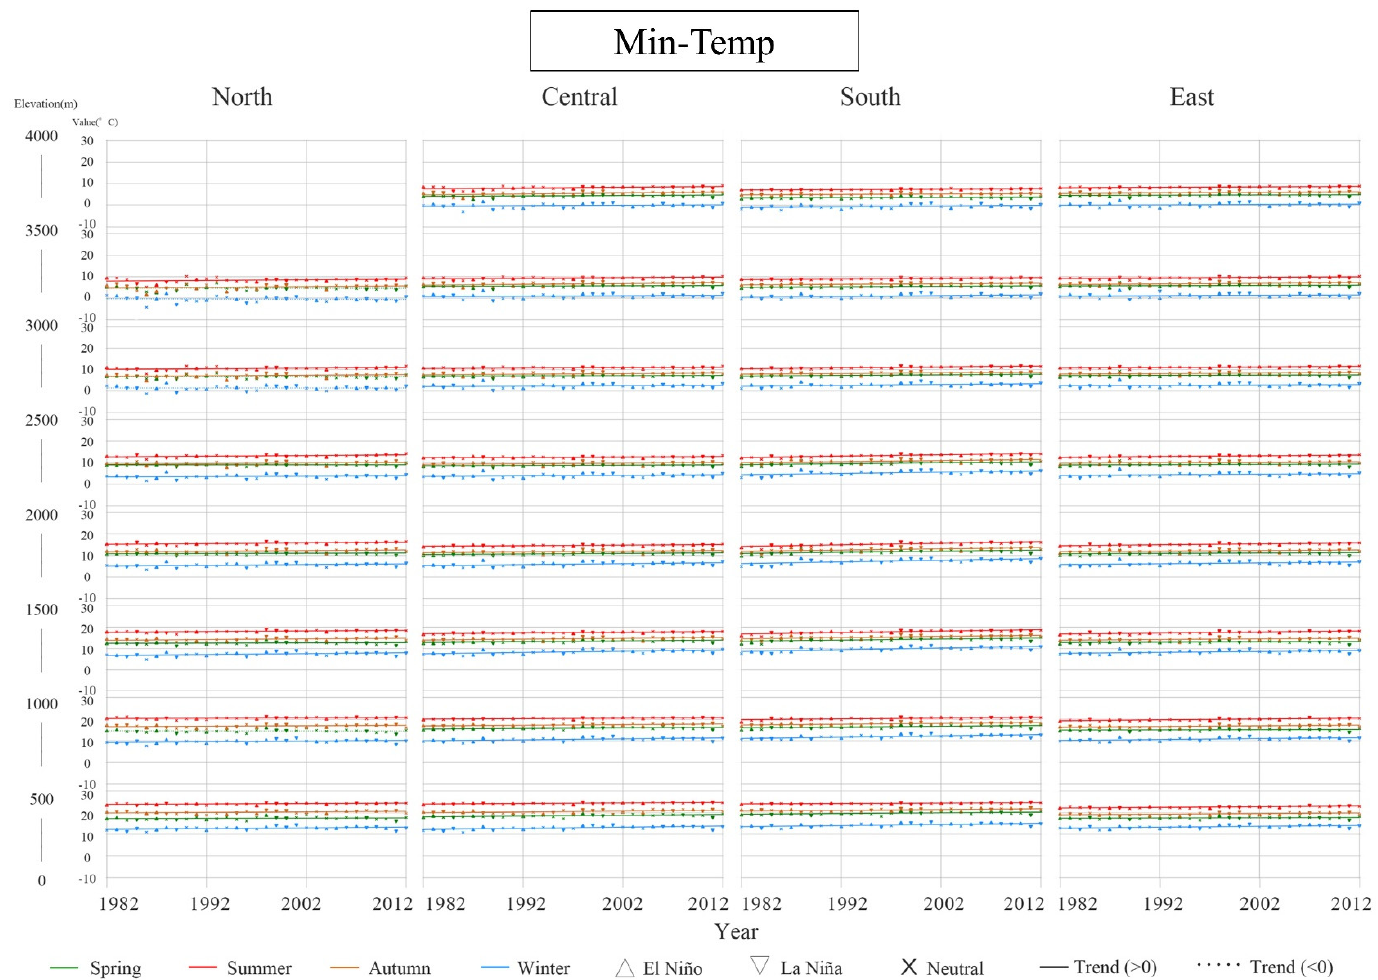
Figure 13. Regional and seasonal linear regression results for the minimum temperature at varied elevations.